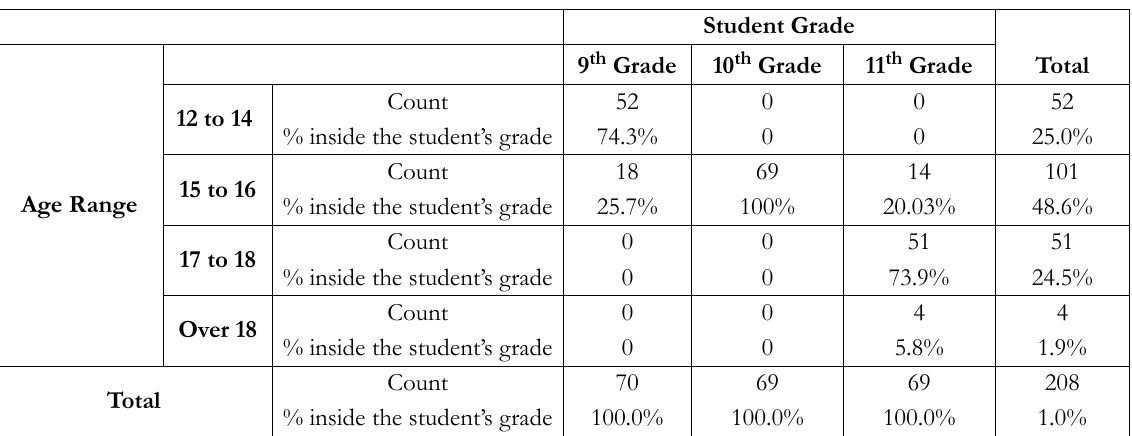
Table 2. Contingency table, age-range